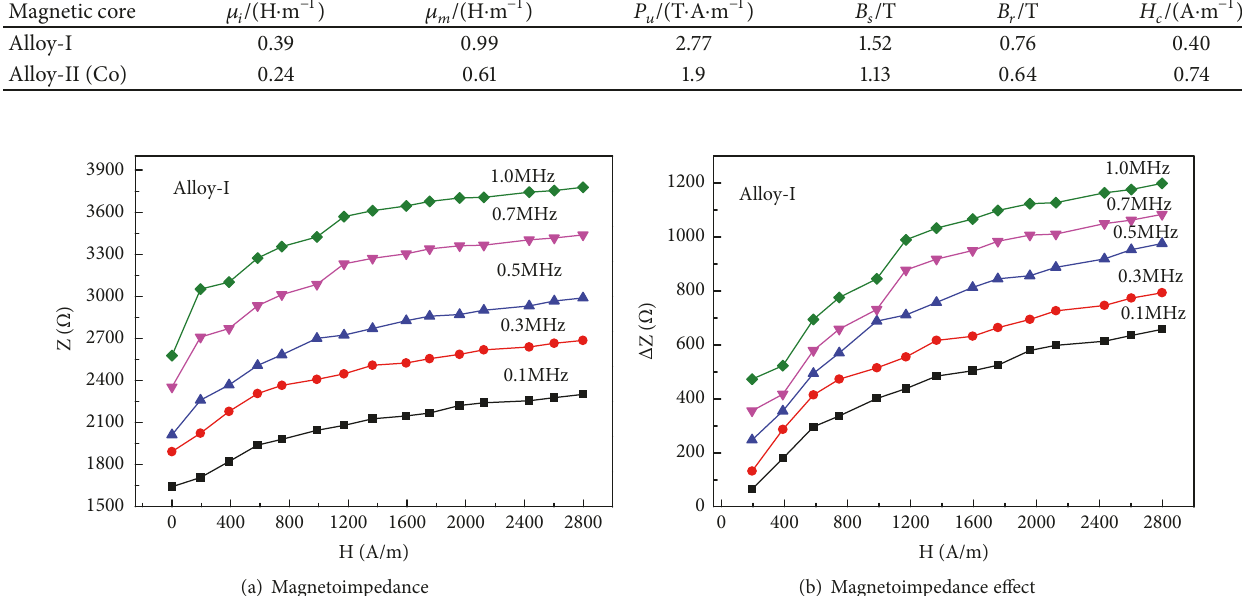
Figure 5: The magneto impedance effect of the Alloy-I amorphous/nanocrystalline strips after heat treatment at 550 ∘ C.